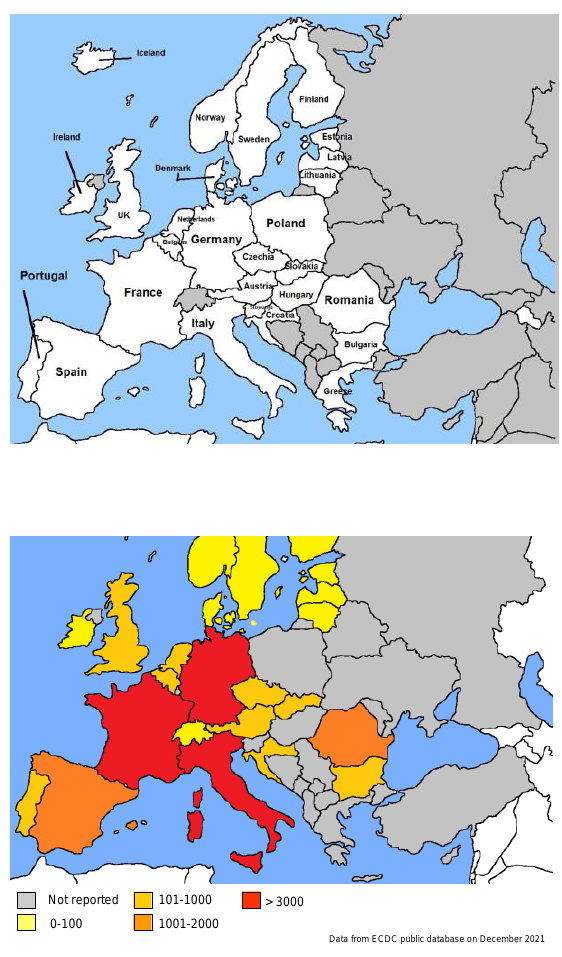
Figure 1. European countries considered in the study: top: map; bottom: ICUs.